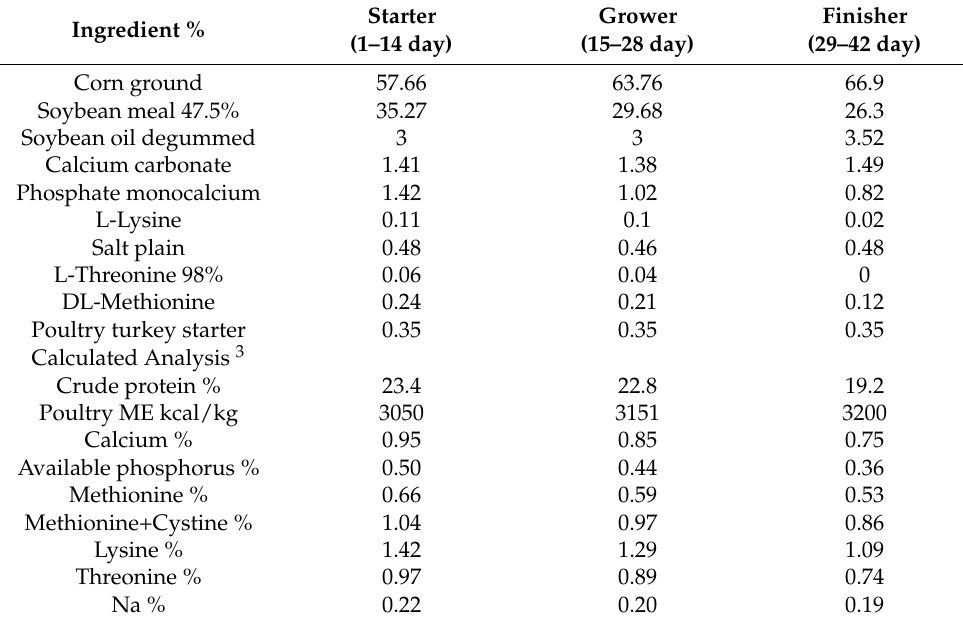
Table 1. Components of base diet 1 , separated by the growth phase 2